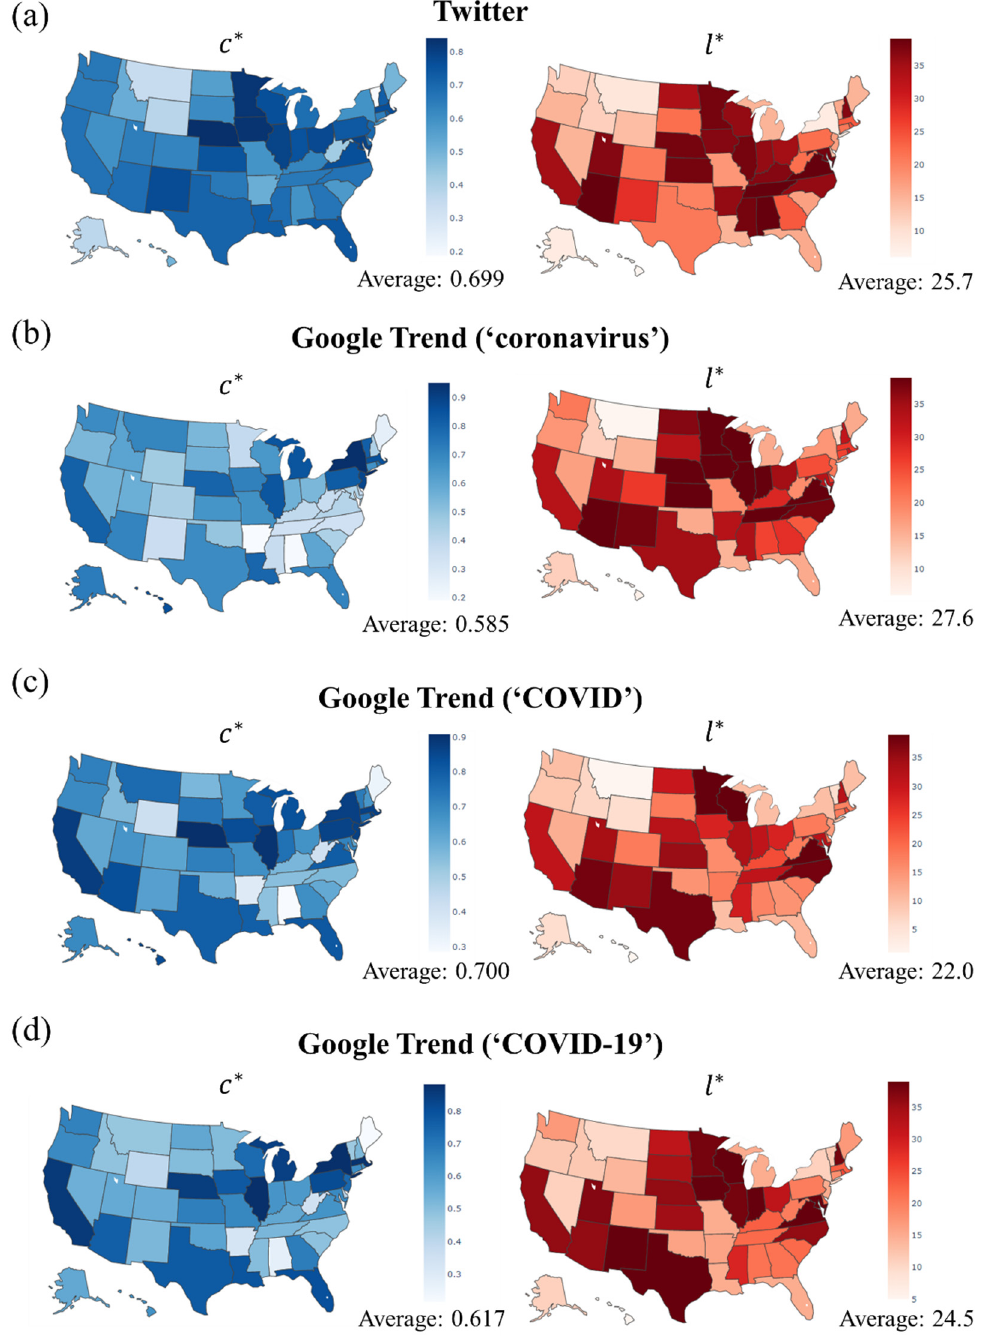
Figure 3. The distribution of 𝑐 ∗ and 𝑙 ∗ over 50 states for ( a ) Twitter and ( b – d ) Google Trends with different keywords.